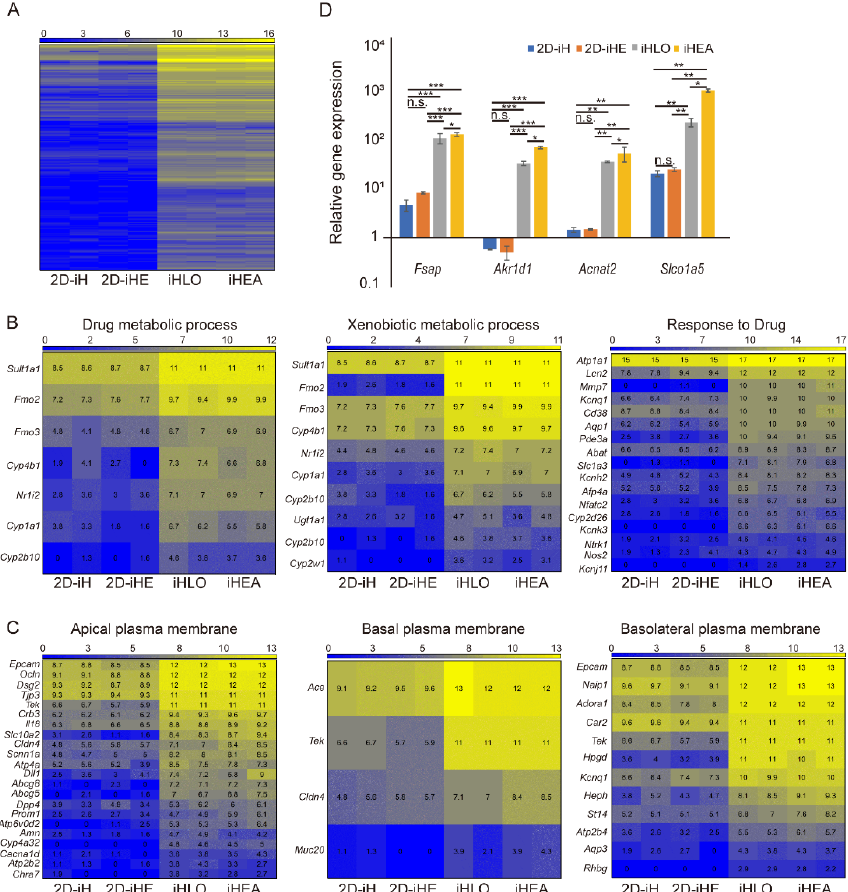
Figure 4. Gene expression of cell–ECM, cell–cell signaling-related genes, and hepatic-specification genes associated with FN1 expression of iHLOs and iHEAs. ( A ) Heatmap of differentially upregu- lated gene profiles in 2D-iHs, 2D-iHEs, iHLOs, and iHEAs as determined by RNA-seq. The Heatmap represents differentially expressed genes between 2D-iHs, 2D-iHEs, iHLOs, and iHEAs depending on the culture method (2D vs. 3D). The color bar codifies the gene expression in log2 scale. Yellow indicates upregulated genes, and blue indicates downregulated genes. ( B ) Heatmaps of differentially upregulated genes classified in three GO functional categories: “drug metabolic process,” “xenobiotic metabolic process,” and “response to drugs”. The color bar codifies the gene expression in log2 scale. Yellow indicates upregulated genes, and blue indicates downregulated genes. ( C ) Heatmaps of differentially upregulated genes classified in three GO functional categories: “apical plasma membrane,” “basal plasma membrane,” and “basolateral plasma membrane”. The color bar codifies the gene expression in log2 scale. Yellow indicates upregulated genes, and blue indicates downregulated genes. ( D ) qPCR analysis of selected highly expressed genes in iHEAs and iHLOs relative to MEFs. The transcriptional levels were normalized to the housekeeping gene ( Gapdh ). Error bars indicate standard errors from triplicate samples ( n = 3). * p < 0.05, ** p < 0.005, *** p < 0.0005, n.s. = not significant.